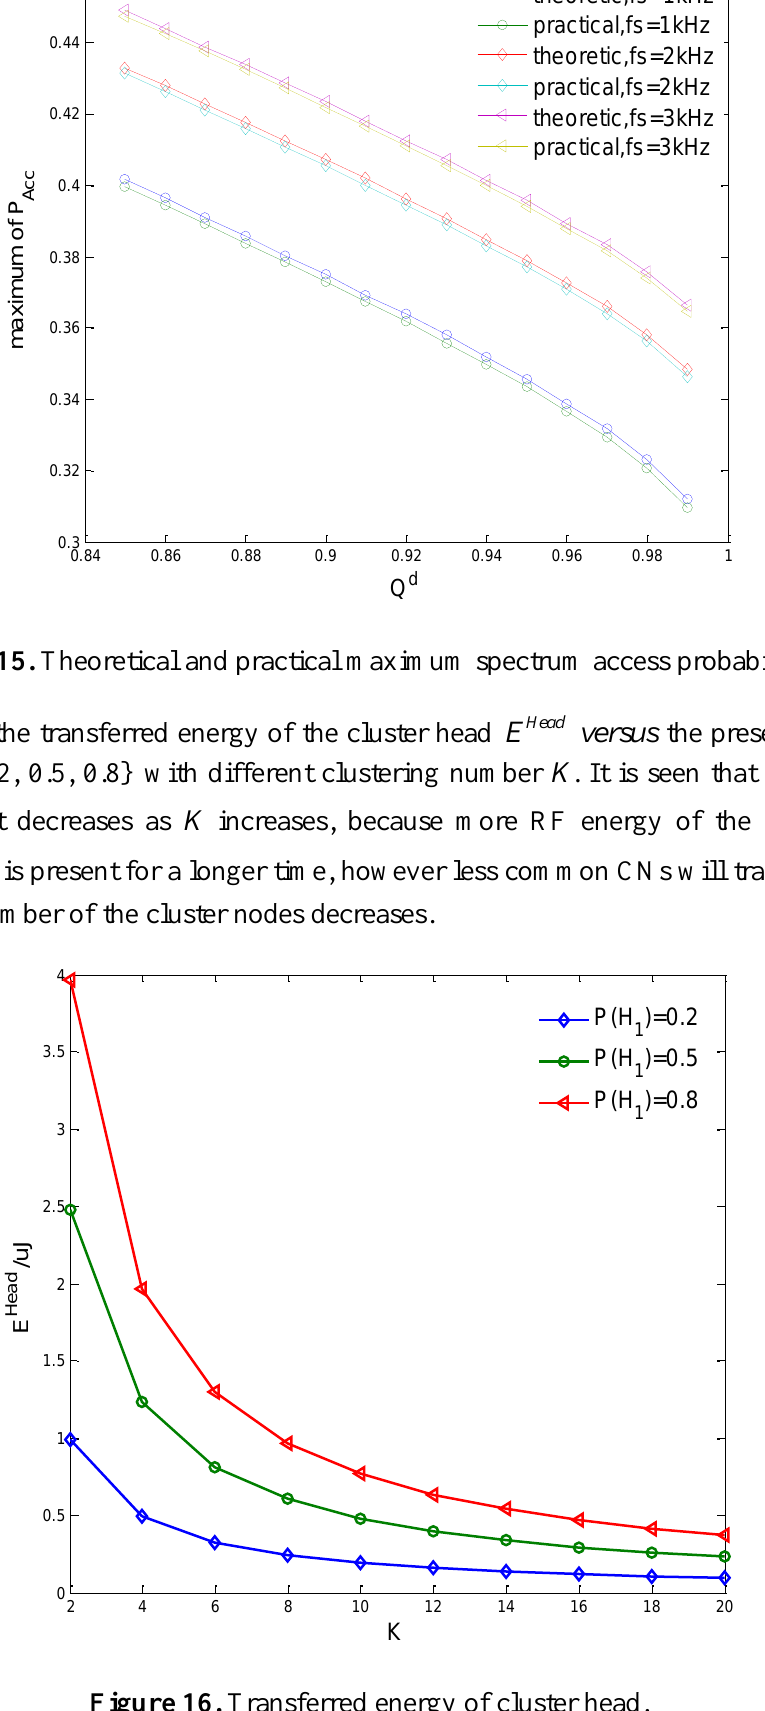
Figure 16. Transferred energy of cluster